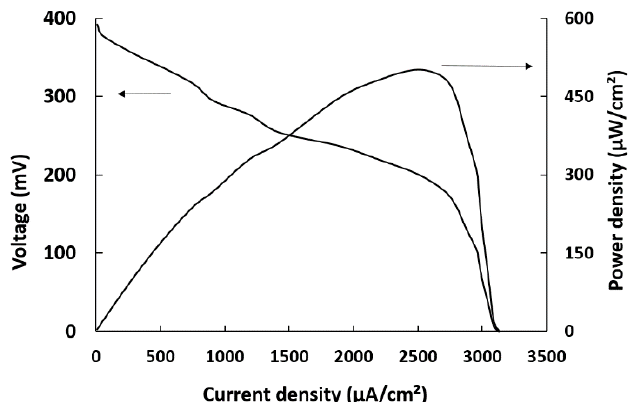
Figure 3. Current density-voltage and power density-current characteristics for standard 5 mM glucose solution in air-saturated environment. pH = 7.4.